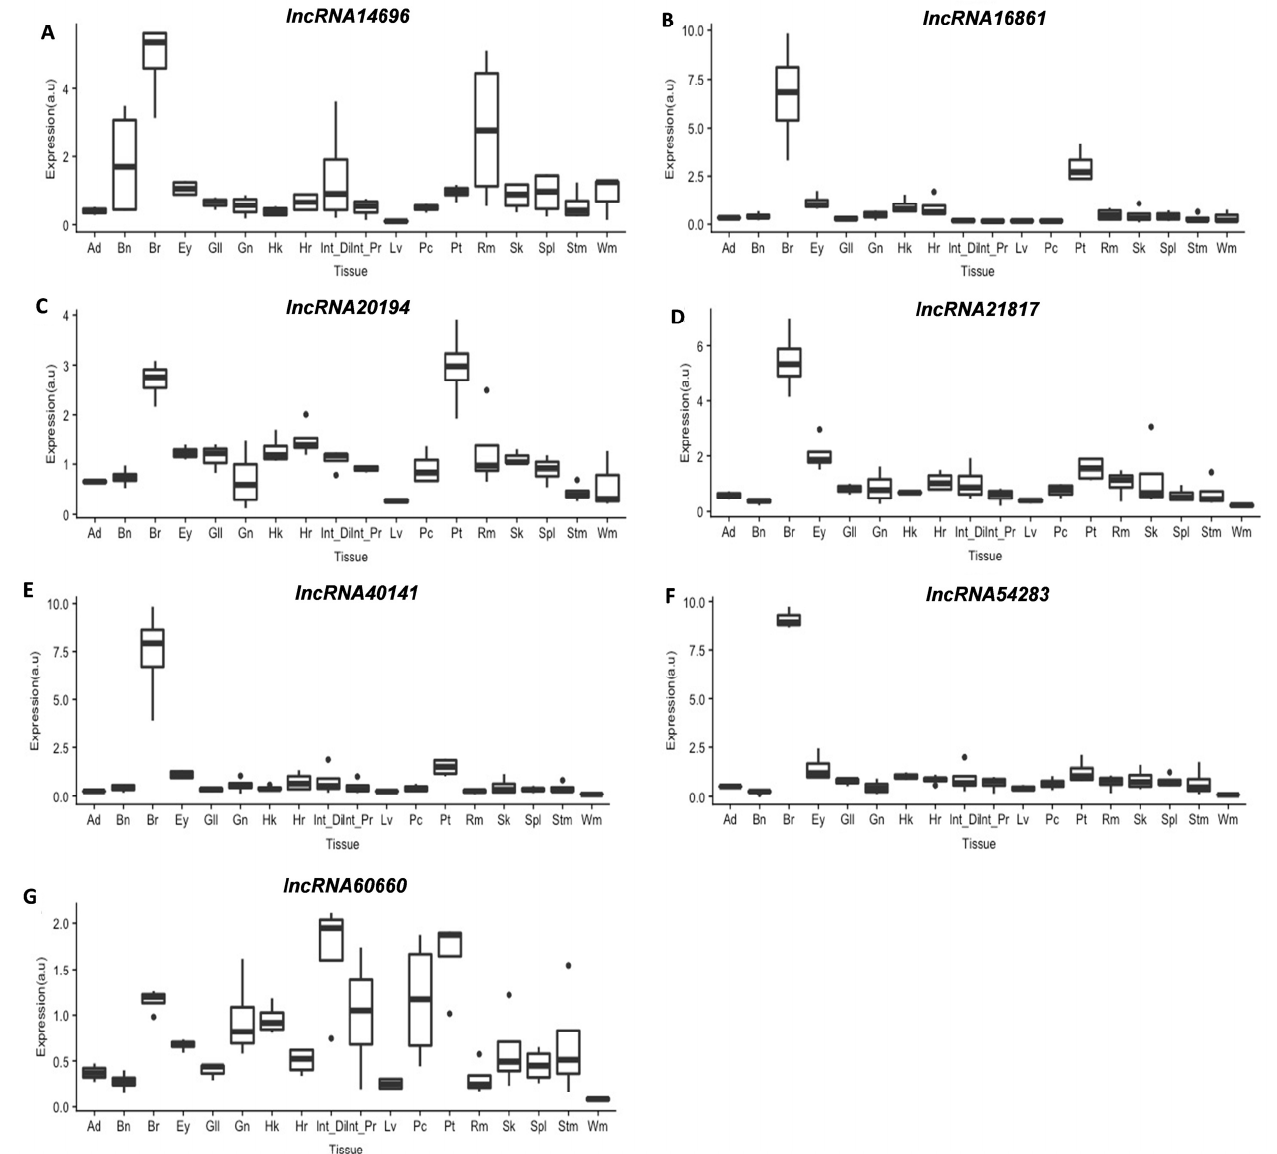
Figure 4. Boxplots showing lncRNAs expression in different gilthead sea bream tissues ( n = 4) ( A – G ): Ad (Adipose tissue), Bn (Bone), Br (Brain), Ey (Eye), Gl (Gills), Hk (Head kidney), Hr (Heart), Int_Di (Distal Intestine), Int_Pr (Proximal Intestine), Lv (Liver), Pc (Pyloric caeca), Pt (Pituitary), Rm (Slow muscle), Sk (Skin), Spl (Spleen), Stm (Stomach), and Wm (Fast muscle). Gene expression is indicated as arbitrary units (a.u). Outliers are presented as